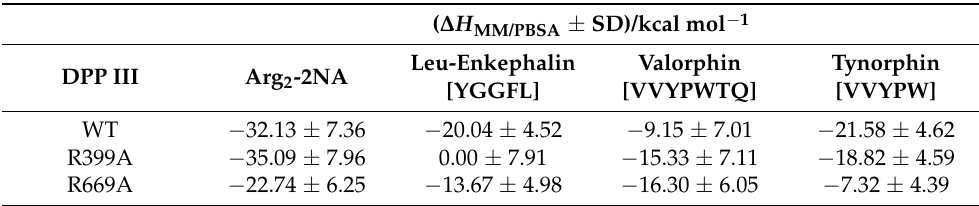
Table 2. The ligand binding enthalpy calculated using the MM/PBSA approach for the last 800 ns of MD simulations (for structures sampled every 100 ps).